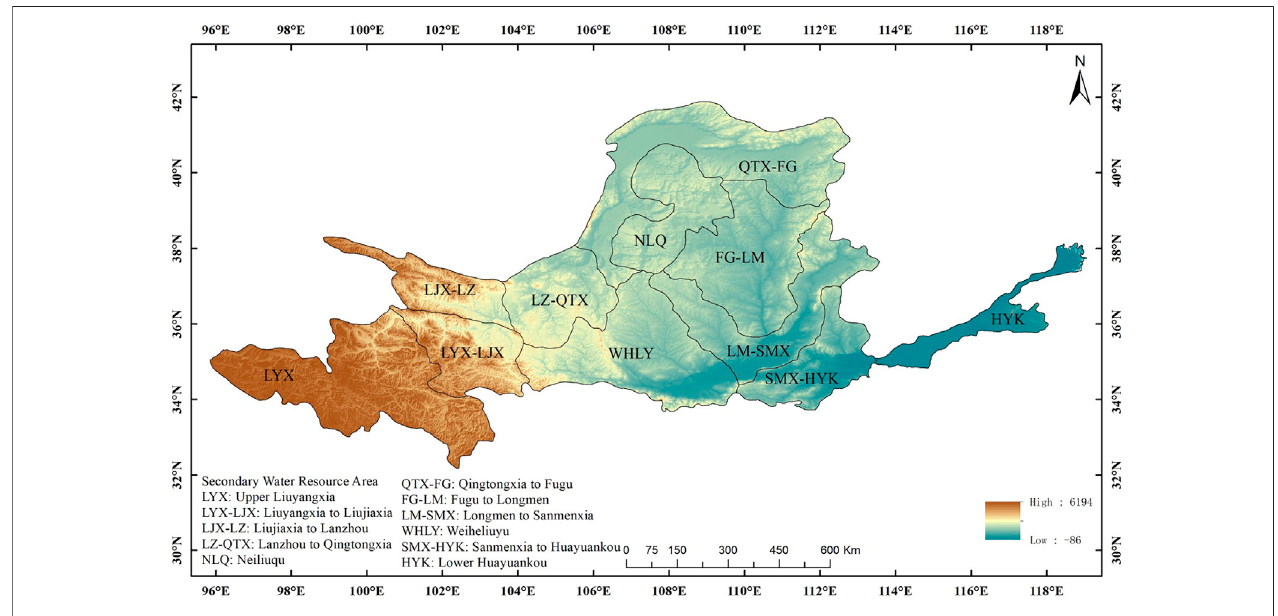
FIGURE 1 | Terrain and secondary water resource areas of the Yellow River Basin.